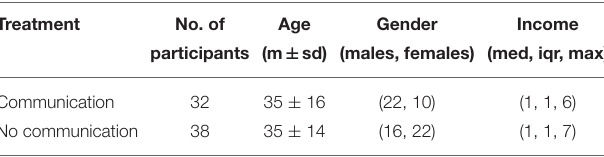
TABLE 2 | Overview of the different experimental sessions per treatment and average payoffs the participants earned during each session.